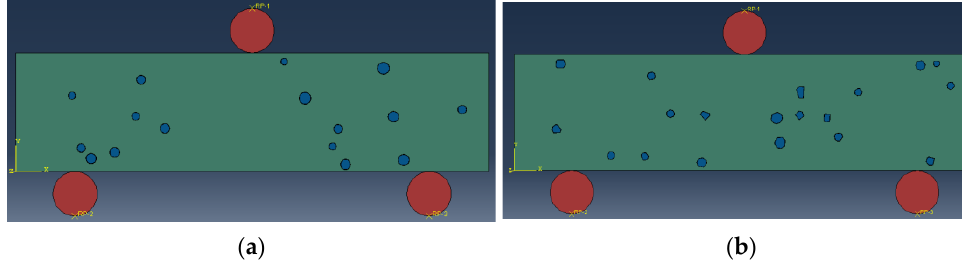
Figure 7. CRM specimens for three-point flexural test. ( a ) CRM 6 with circular rubber particles. ( b ) CRM 6 with circle-derived polygonal rubber particles.